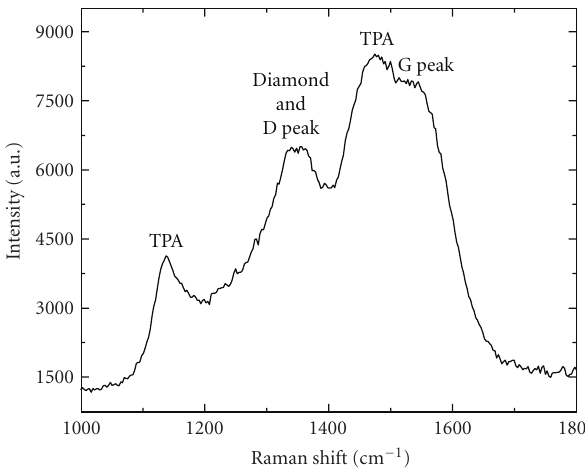
Figure 3: Raman spectrum of undoped NCD film grown on a silicon